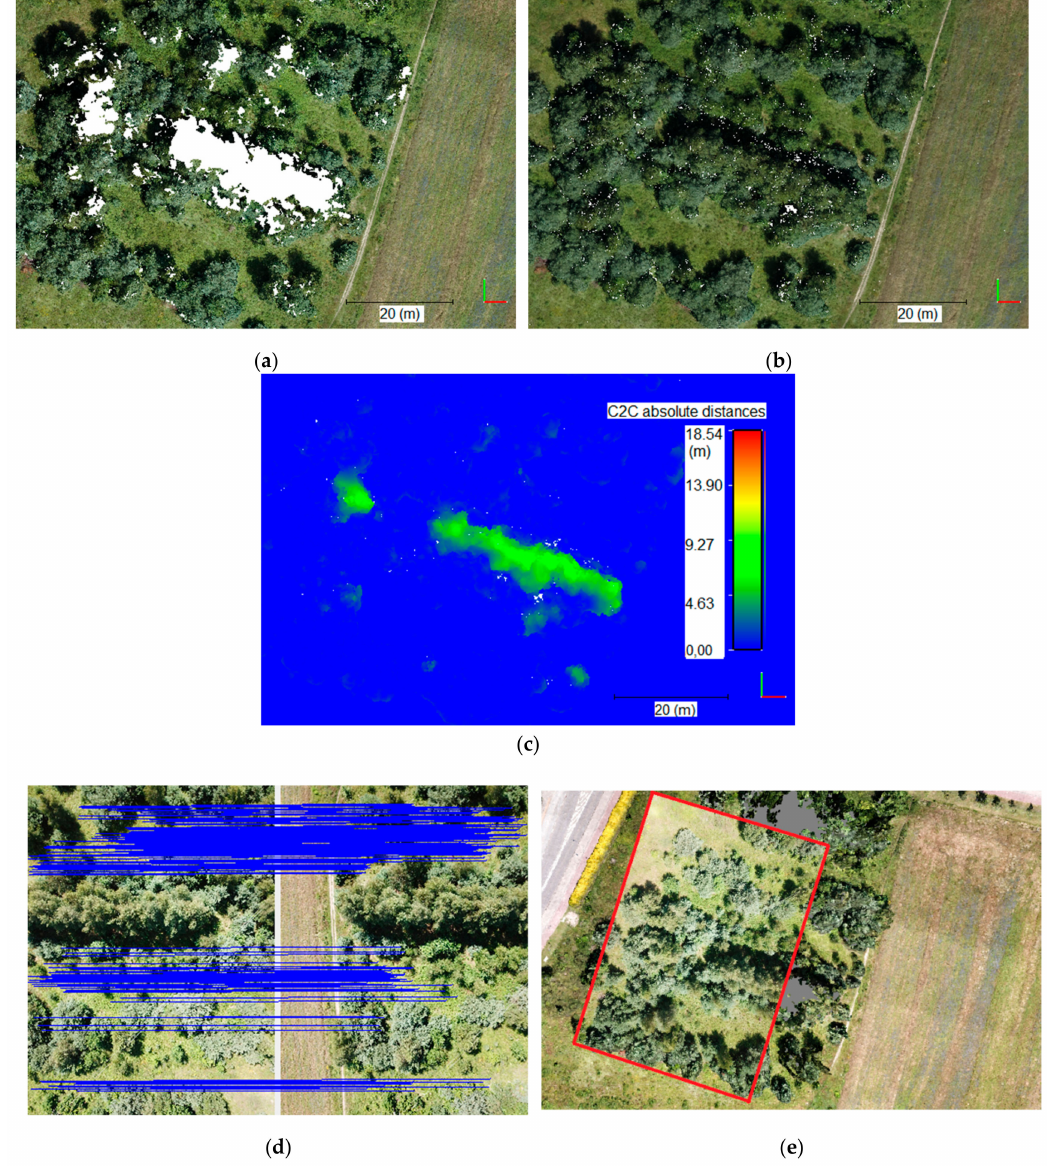
Figure 8. Bushes problem ( a ) point cloud from 55 m, ( b ) point cloud from 110 m, ( c ) C2C comparison (55 m to SR), ( d ) matches between images (55 m), and ( e ) point cloud and respective image overlaid (55